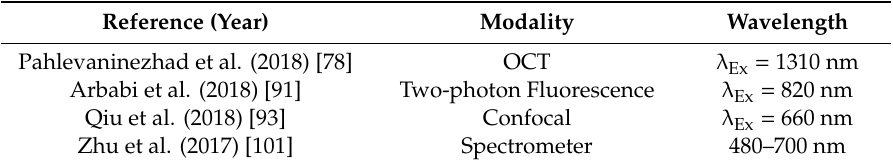
Table 3. Metalens-based optical imaging and sensing